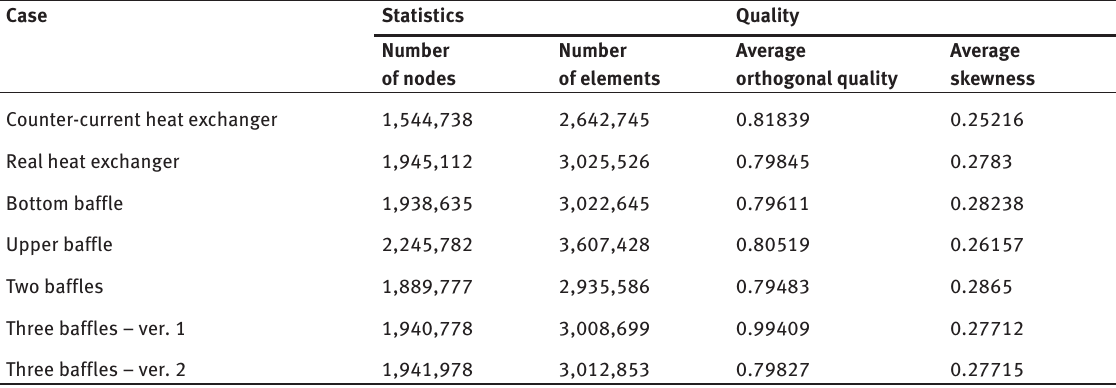
Table 1: Mesh statistics and quality.